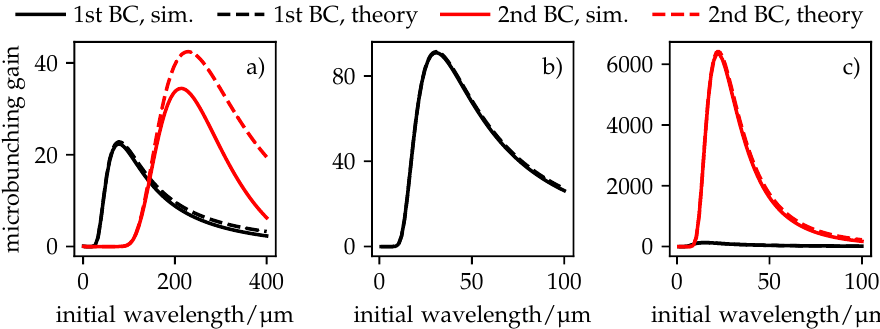
Figure 2. Microbunching gain after the first and second bunch compression stage for ( a ) the FLASH2020+ linac, ( b ) FERMI in usual configuration featuring only a single bunch compression stage, ( c ) FERMI in double compression scheme. Simulation results were obtained from a dedicated non-linear Vlasov solver [71], while the analytical results are based on a linear perturbation